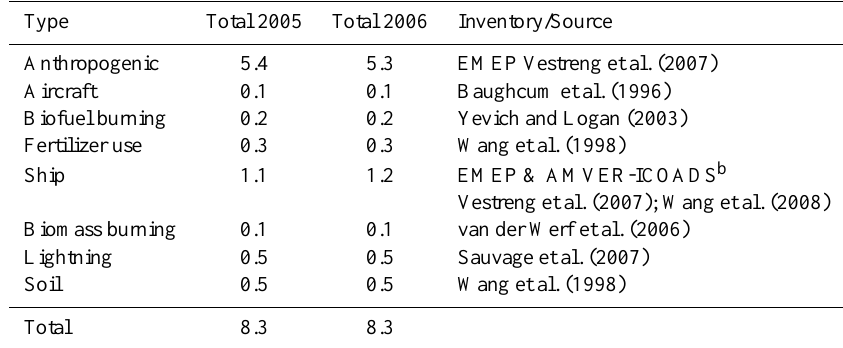
Table 1. Overview of total European 2005–2006 NO x emissions used in this study (TgNyr − 1 ) a